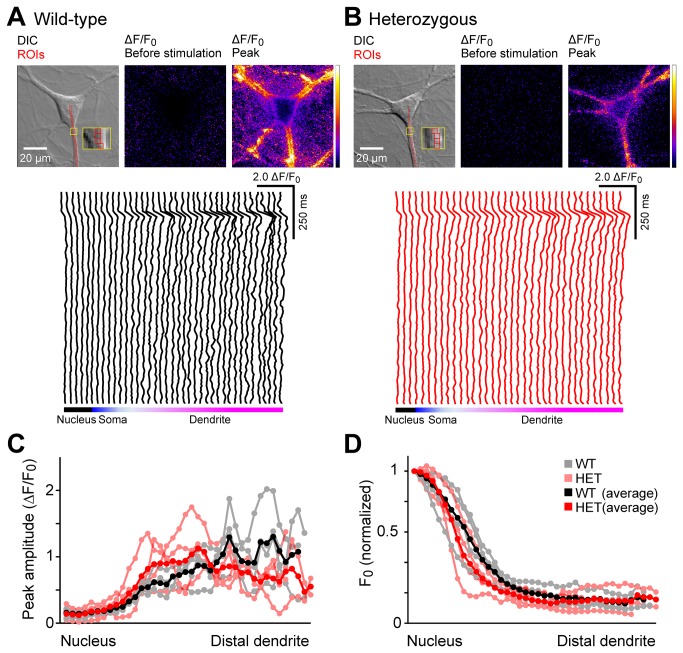
Subcellular [Ca2+]c gradients are not affected by the ΔE-torsinA mutation.(A and B) A wild-type (A) and heterozygous neuron (B) analyzed as in Figure 1A, but without spatial averaging. The DIC images show an overlay of a series of individual pixels assigned from the center of the soma (corresponding to the nucleus), through the soma and ending in a dendrite. The insets show a magnified view of the yellow rectangle depicted in the proximal dendrite. The lower panels show the [Ca2+]c transients at individual pixels when the neurons were stimulated with a single field-stimulation pulse. The position of the pixels is indicated schematically at the bottom of each trace. (C) The peak amplitudes in individual neurons were plotted against the position relative to the nucleus. (D) Baseline fluorescence intensity (F0) in individual neurons was normalized and plotted against the position relative to the nucleus. In panels C and D, each data point represents a pixel. Gray and black symbols represent the raw and averaged data from wild-type neurons, whereas pink and red symbols represent the raw and averaged data from heterozygous neurons.